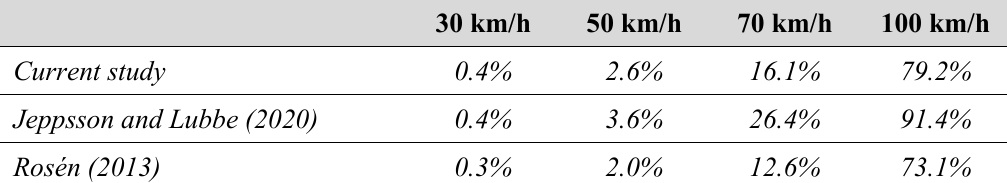
Table 6. Comparison of cyclist fatality risks to previous